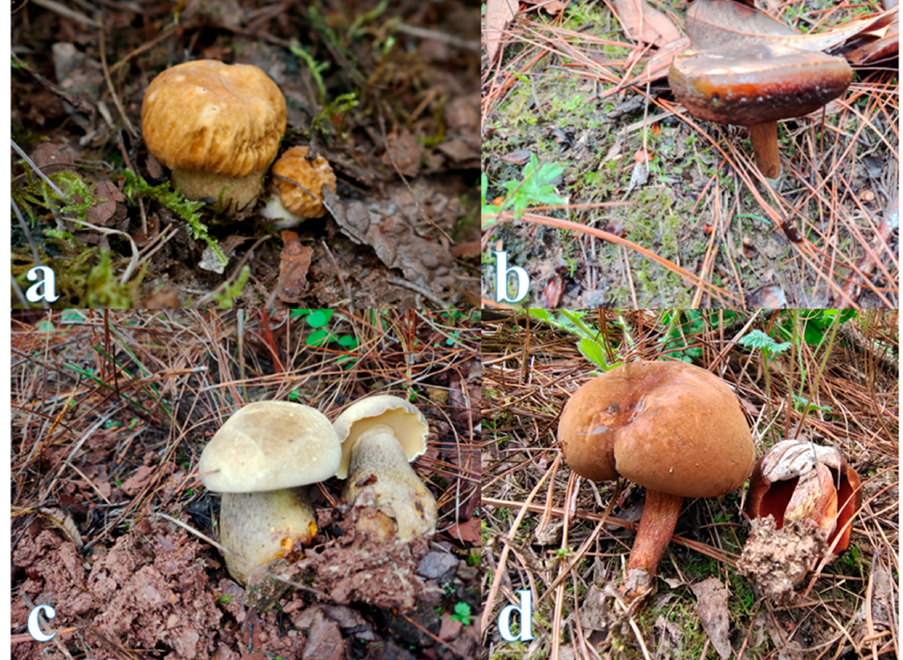
Figure 2. Wild edible mushroom growing environment. ( a ) Boletus bainiugan ; ( b ) Neoboletus brun- neissimus ; ( c ) Retiboletus fuscus ; ( d ) Xerocomus species. Figure 2. Wildediblemushroomgrowingenvironment. ( a ) Boletus bainiugan ; ( b ) Neoboletus brunneissimus ; ( c ) Retiboletus fuscus ; ( d ) Xerocomus species.